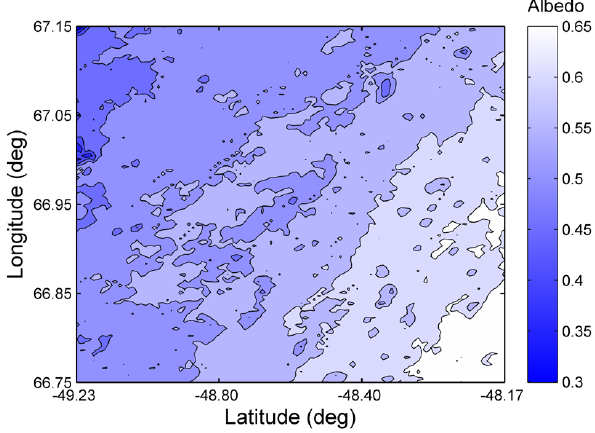
Figure 13. Observed ablation rates and broadband α ASD for differ- ent ice surface